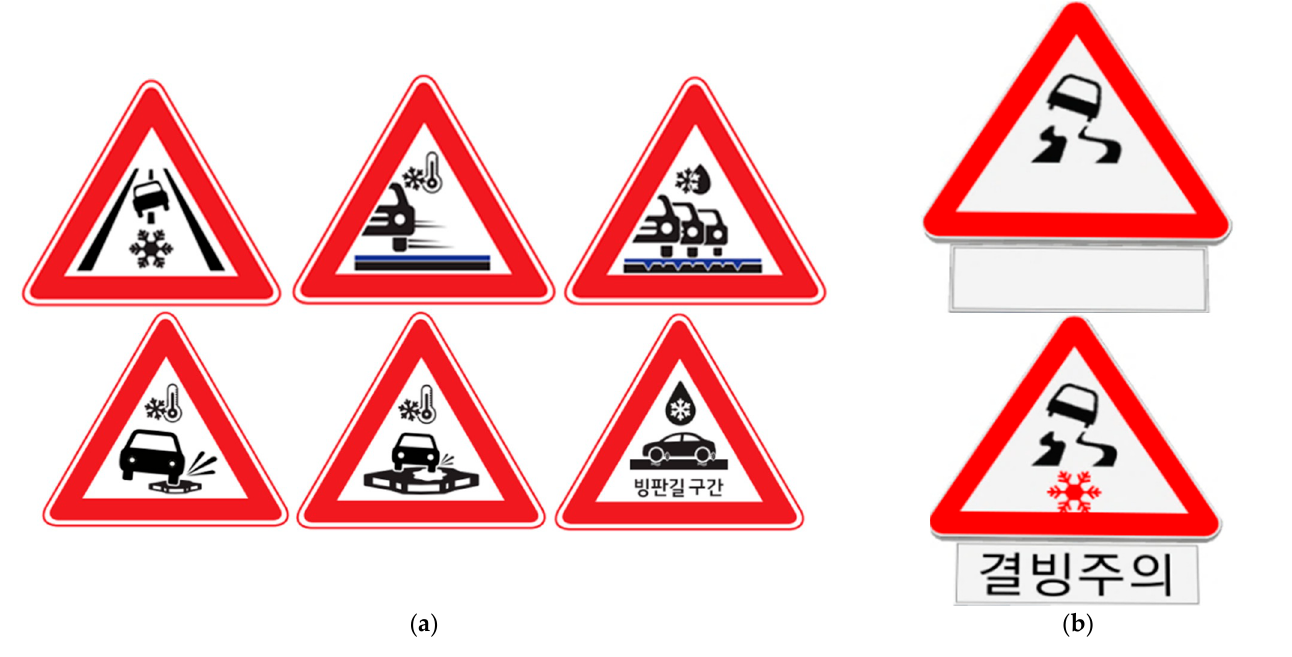
Figure 2. Study signs for each experiment step: ( a ) six versions of new warning signs actuated by weather conditions; ( b ) final selected design for new warning sign before actuation ( top ) and after actuation by freezing temperatures ( bottom ) ; The Korean sign means “Caution on Black Ice”.